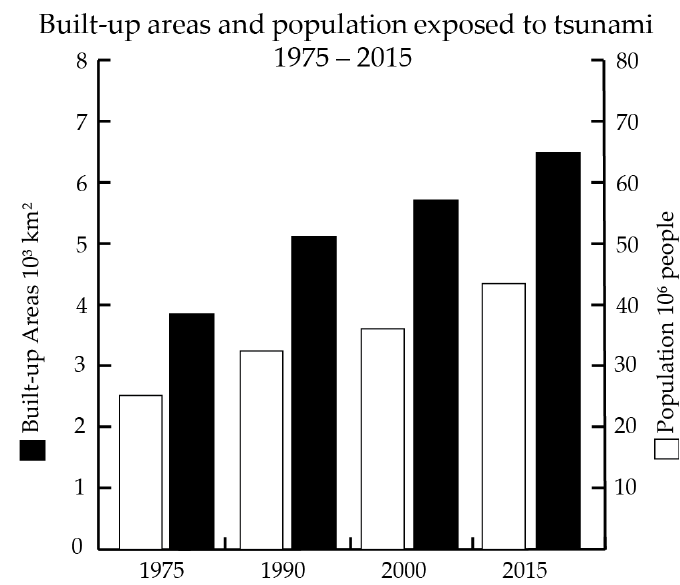
Figure 5. Built-up area (left) and population (right) in areas potentially affected by tsunamis Run-up and inundation.